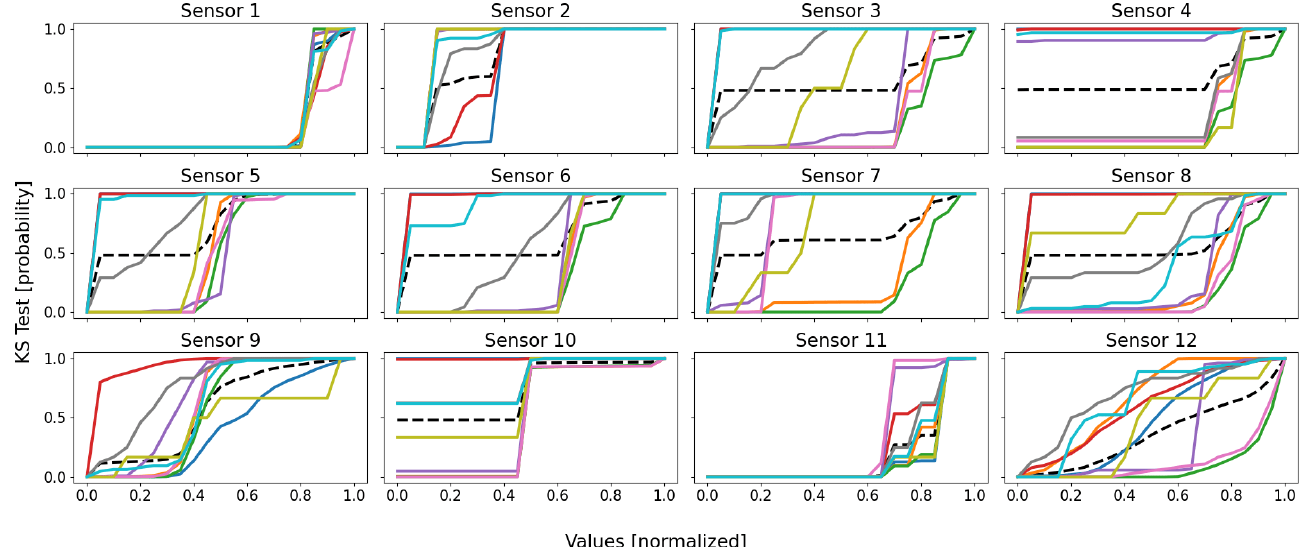
Figure 8. Battery 2 probability distributions. The solid colored lines are the empirical distributions of each cluster, and the black dashed line is that of the database D 2 . The real normalized values of the corresponding sensor are in abscissa, and their respective probabilities of appearance are in